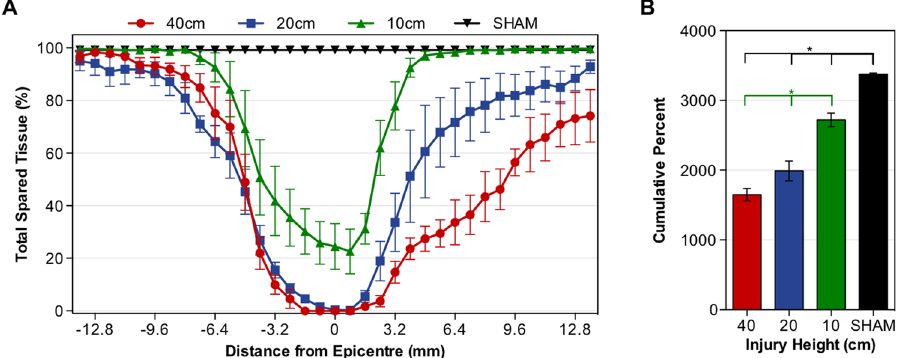
Figure 3. Effect of injury severity on tissue sparing 12 weeks after spinal cord injury. Spared tissue was measured using Eriochrome Cyanine stained sections from 13.6 mm rostral and 13.6 mm caudal to the site of injury. ( A ) The total spared tissue in percent, relative to the entire area of the spinal cord of the same section was calculated for the 40 (red), 20 (blue), 10 cm (green), and SHAM (black) groups. ( B ) The total amount of tissue sparing (cumulative percent) was calculated using the area under the curve of total spared tissue (%) for the 40 (red), 20 (blue), 10 cm (green), and SHAM (black) groups. Asterisks indicate sparing for which significant differences were found between groups with ANOVA. Data is presented as means ± SEM for n = 4 animals per group. SCI, spinal cord